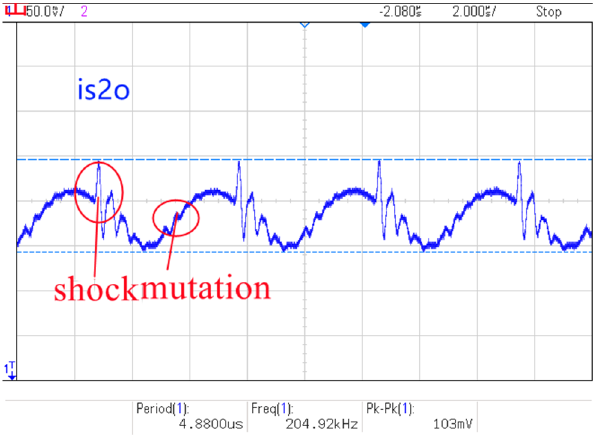
Figure 29. Input current waveform under of traditional topology .